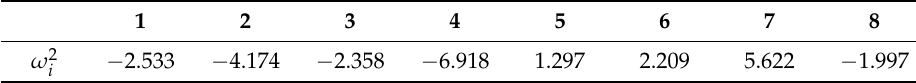
Table 2. Error comparison between the ANN algorithms.